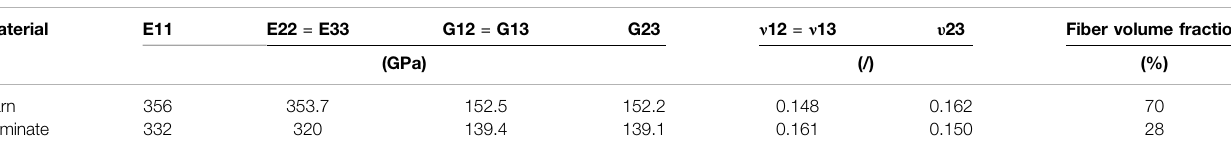
TABLE 2 | Input mechanical properties for yarn and laminate, calculated from micro-UD model.